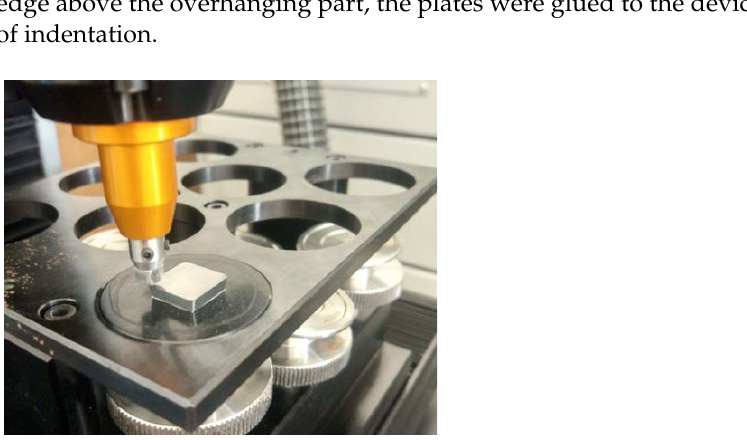
( b ) Figure 4. Final view of microtextures: ( a , b ) the microtexture location on the rake surface. The possibility of combining various methods of tool modification in the form of mi- crotexturing of the surface with a wear-resistant coating was studied. Wear-resistant coat- ings were applied on the Platit p311 installation (PLATIT AG, Selzach, Switzerland). The main problem when applying prints to the surface of plates with wear-resistant coatings may be insufficient adhesion of coatings to the substrate and their cracking and peeling. The multilayer coating nATCRo 3 based on (TiCrAlSi)N proved the best. The nAT- CRo 3 coating combined (CrTi)N and (AlTi)N layer sequence and an (AlTiCr)N/SiN nano- composite coating. A two-phase structure of the last layer is constituted by (AlTiCr)N crystals with a grain size of up to 5 nm and is distributed equally to Si 3 N 4 in the amorphous phase. The phase interfaces are the area of intensive dissipation of energy, diverging the cracks in the coating from their paths, and inhibiting their propagation rate, which leads to the hardening of the material. When indenting, it turned out to choose a variant of the microtexture density that did not cause the formation of noticeable micro-cracks on the surface of the plates. Plates with this kind of coating were tested in experiments. 2.3. Selection of Modes and Measurement of Processing Parameters The processing modes were selected from the conditions of finishing turning with small feed (0.1, 0.125, and 0.15 mm/rev) and cutting depth values (0.3, 0.4, and 0.5 mm). The cutting speed (17, and 27 m/min) was chosen with the recommended values from the manufacturer of the cutting plates and subsequently changed for turning conditions of